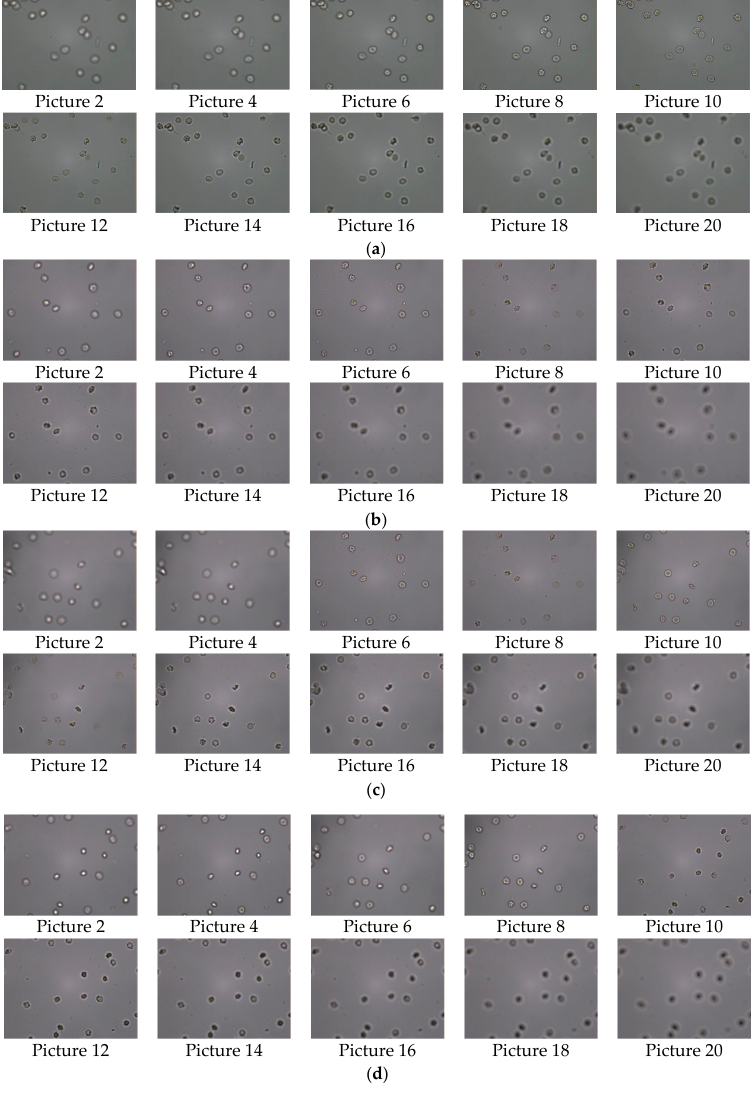
( d ) Figure 5. Sharpness evaluation curve of each algorithm for the four groups of images: ( a ) Group 1; ( b ) Group 3; ( c ) Group 4; ( d ) Group 9. In order to verify that the algorithm is feasible on other types of images, two sets of public data and two sets of biomedical cell images with different contents are selected for testing. The experimental images and results are shown in Figure 6. Furthermore, Re- dondo et al. [41] defined the ratio of the width of the evaluation curve at 40% and 80% as a narrow width 𝛼 𝛽⁄ , which can objectively reflect the performance of the algorithm. The values of the narrow width of the algorithms in the urinary sediment cell dataset, the pub- lic dataset, and biomedical cell images are shown in Tables 1 and 2 below. The average time consumed by each algorithm is given in the tables. 0